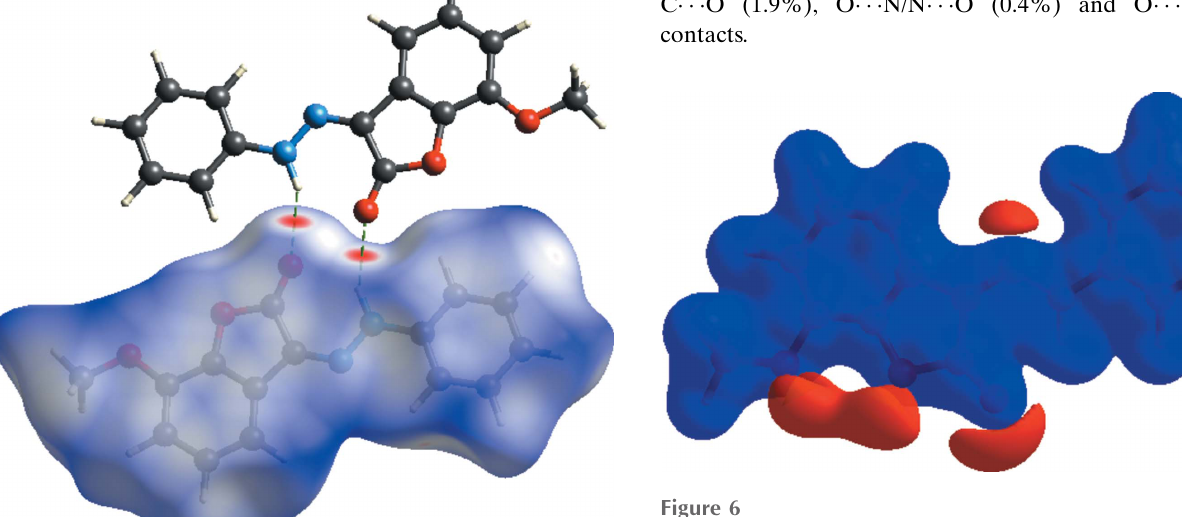
Figure 6 View of the three-dimensional Hirshfeld surface of the title compound plotted over electrostatic potential energy in the range (cid:4) 0.0500 to 0.0500 a.u. using the STO-3 G basis set at the Hartree–Fock level of theory. The hydrogen-bond donors and acceptors are viewed as blue and red regions, respectively, around atoms, corresponding to positive and negative potentials.